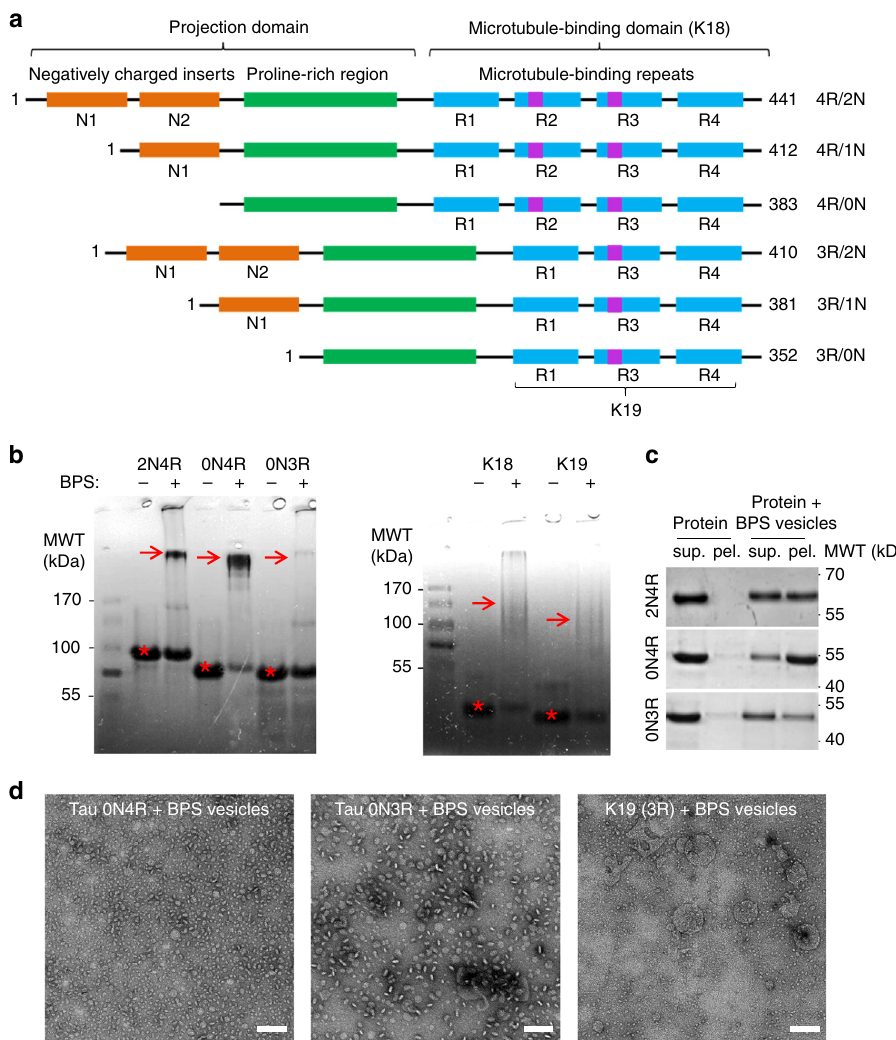
Fig. 4 Tau isoforms lacking the R2 domain are de fi cient in the formation of protein/phospholipid complexes. a Human Tau naturally occurs in six isoforms, depending on the alternative splicing of exons E2, E3, and E10, giving rise to the variants containing either 0, 1, or 2 N-terminal inserts (0N, 1N, and 2N), and 3 or 4 microtubule-binding repeats (3R and 4 R). b NativePAGE analysis of protein incubated alone or with BPS vesicles at a molar protein:phospholipid ratio of 1:20. The Tau 0N4R isoform was able to form protein/phospholipid complexes as ef fi ciently as the WT protein, while Tau 0N3R and K19 formed signi fi cantly less complexes. The monomer bands, are indicated by asterisks, and the presence of higher molecular weight bands, indicated by arrows. c Co-sedimentation assay of BPS vesicles mixed with the three Tau isoforms (from top to bottom: Tau 2N4R, Tau 0N4R, and Tau 0N3R) at a molar protein: phospholipid ratio of 1:100. When incubated alone (left), all proteins remained in the supernatant (sup.), but in the presence of vesicles (right), the proteins partially co-sedimented with the vesicles to the pellet fraction (pel.), indicative of membrane binding. Tau 2N4R and Tau 0N4R co-sedimented more than Tau 0N3R. d EM analysis of Tau 0N4R (left panel), Tau 0N3R (middle panel) and K19 (right panel) mixed with BPS vesicles at a molar protein:phospholipid ratio of 1:20 showed that Tau 0N4R can form protein/phospholipid complexes, while Tau 0N3R formed some large round and bean-like structures, and K19 formed few complexes with many vesicles remaining. The scale bars are 100